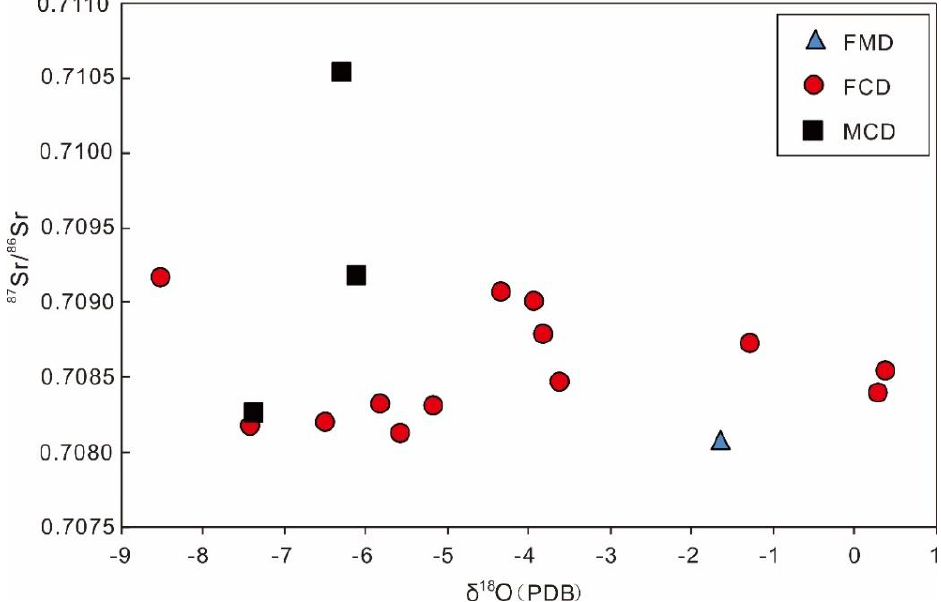
Figure 8. Cross−plot of 87 Sr/ 86 Sr and δ 18 O values for dolomites. FMD: Fine−microcrystalline dolo- Figure 8. Cross − plot of 87 Sr/ 86 Sr and δ 18 O values for dolomites. FMD: Fine − microcrystalline mite; FCD: Fine crystalline dolomite; MCD: Medium crystalline dolomite. dolomite; FCD: Fine crystalline dolomite; MCD: Medium crystalline